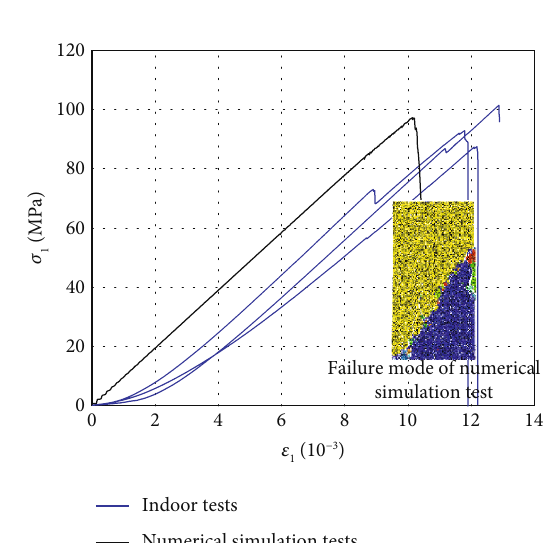
− ε laboratory test, curve of σ 1 1